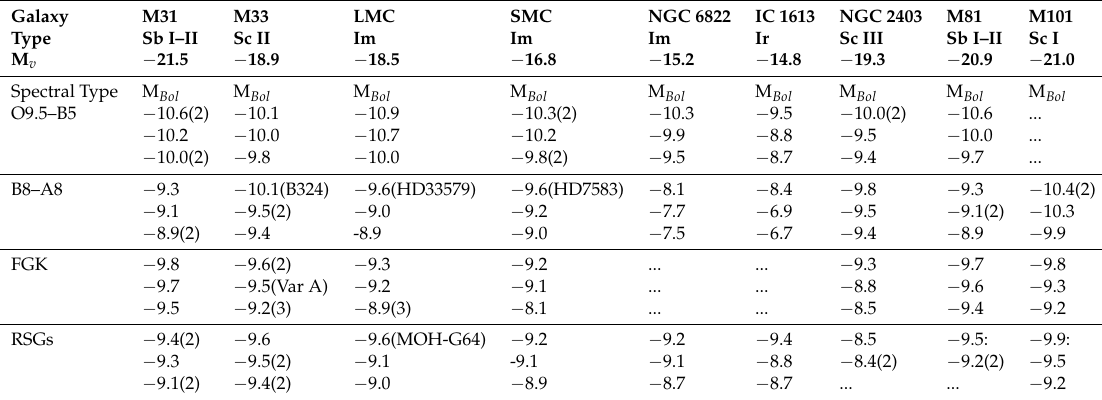
Table 1. The Most Luminous Stars (M Bol ) of Different Spectral